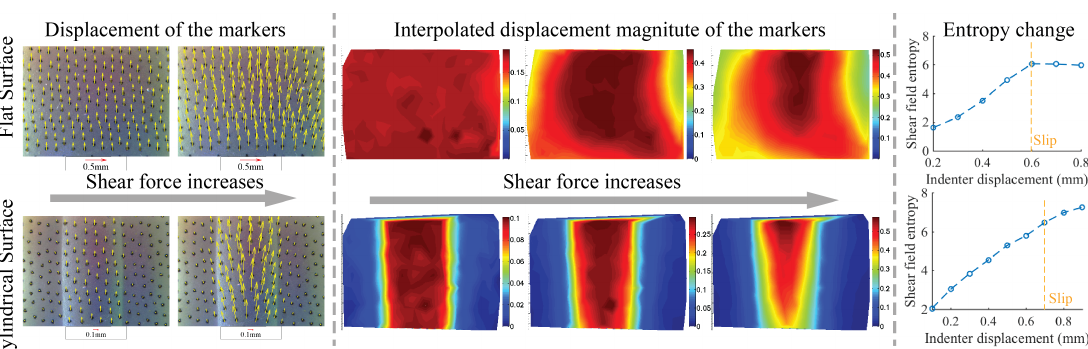
Figure 8. The change of the marker displacement field with the increase of shear force. The degree of partial slip also increases as the force grows, and it starts from the peripheral contact area, which results an inhomogeneity in the marker displacement field. We can measure the inhomogeneity with the entropy of the markers’ displacement, which keeps increasing. The experiment is conducted with a fingertip GelSight sensor [30] whose surface is flat, (Figures adapted from [27] (Got copyright permission from